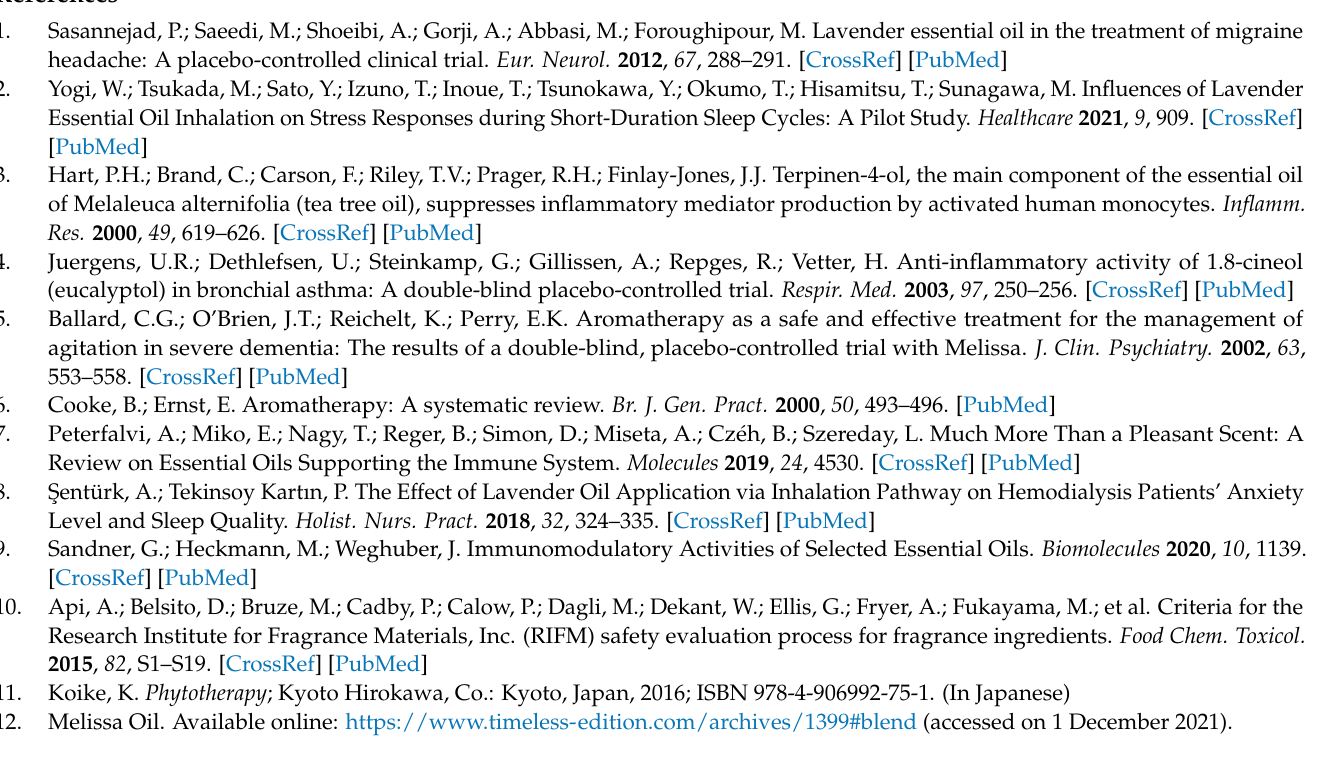
matogram of eucalyptus, Figure S3: GC/MS chromatogram of Melissa; Figure S4: GC/MS spectra of 14 effective